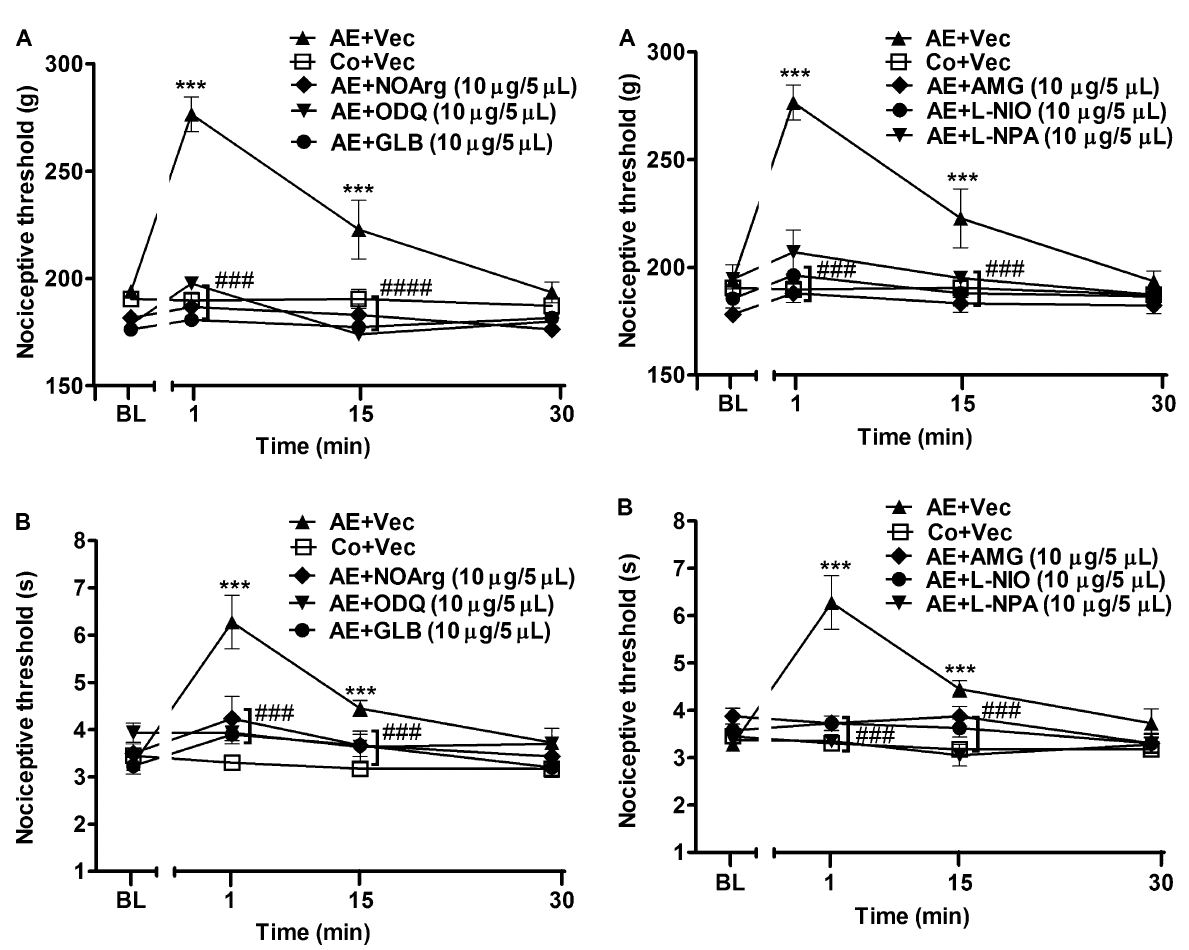
Figure 4. Effect of intracerebroventricular administration of specific NOS inhibitors on the antinociception induced by acute aerobic exercise (AE) in the paw-withdrawal ( A ) and tail-flick ( B ) tests. Rats were pretreated with intracerebroventricular injection of aminoguanidine (AMG, 10 m g/5 m L), N 5 -(1- iminoethyl)-L-ornithine dihydrochloride (L-NIO, 10 m g/5 m L) and N v -propyl-L-arginine (L-NPA, 10 m g/5 m L) immediately before the onset of exercise, which lasted for a mean of 43.3±1.0 min. Mechanical and thermal nociceptive thresholds were measured before and after 1, 15, 30 min of AE. Data are reported as means±SE of 6 animals per group. ***P , 0.001, compared to the control group (Co); ### P , 0.001, compared to the AE group (one-way ANOVA followed by the Bonferroni test). Vec: vehicle; BL: baseline